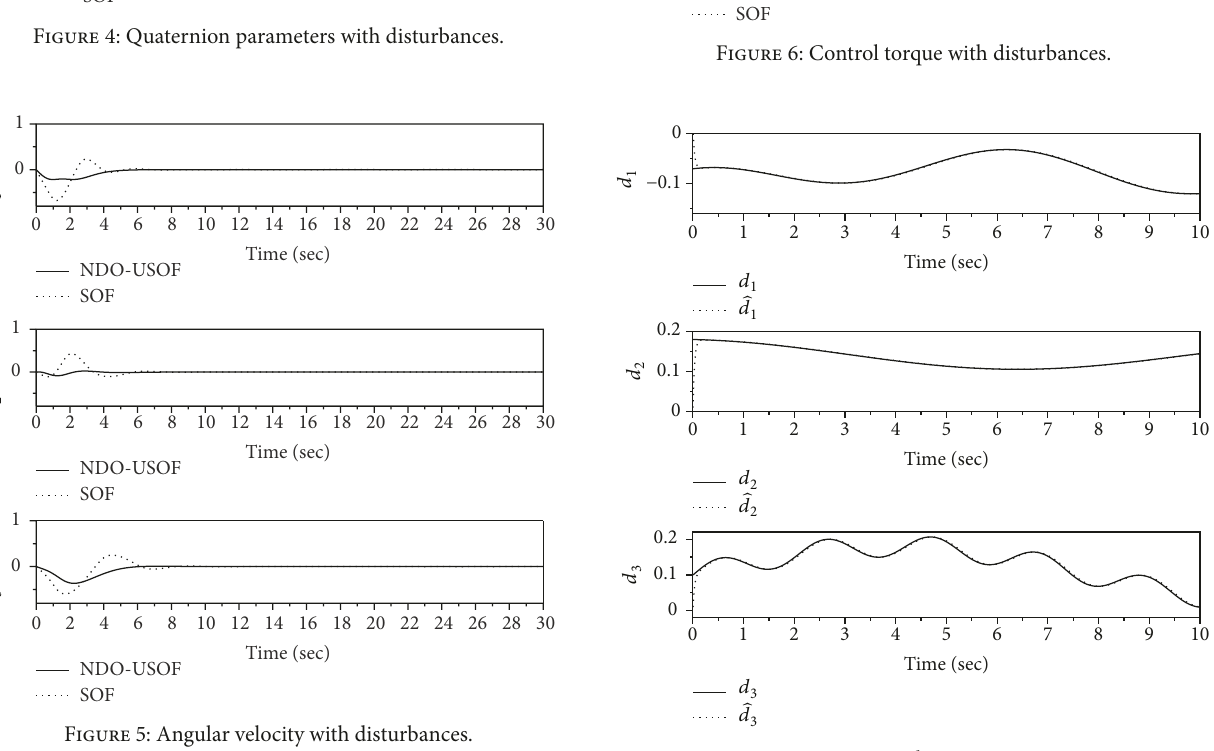
Figure 7: Disturbance